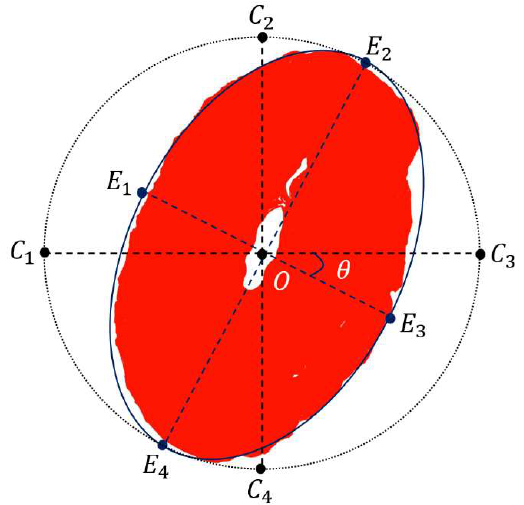
Figure 4. Calibration principle diagram.